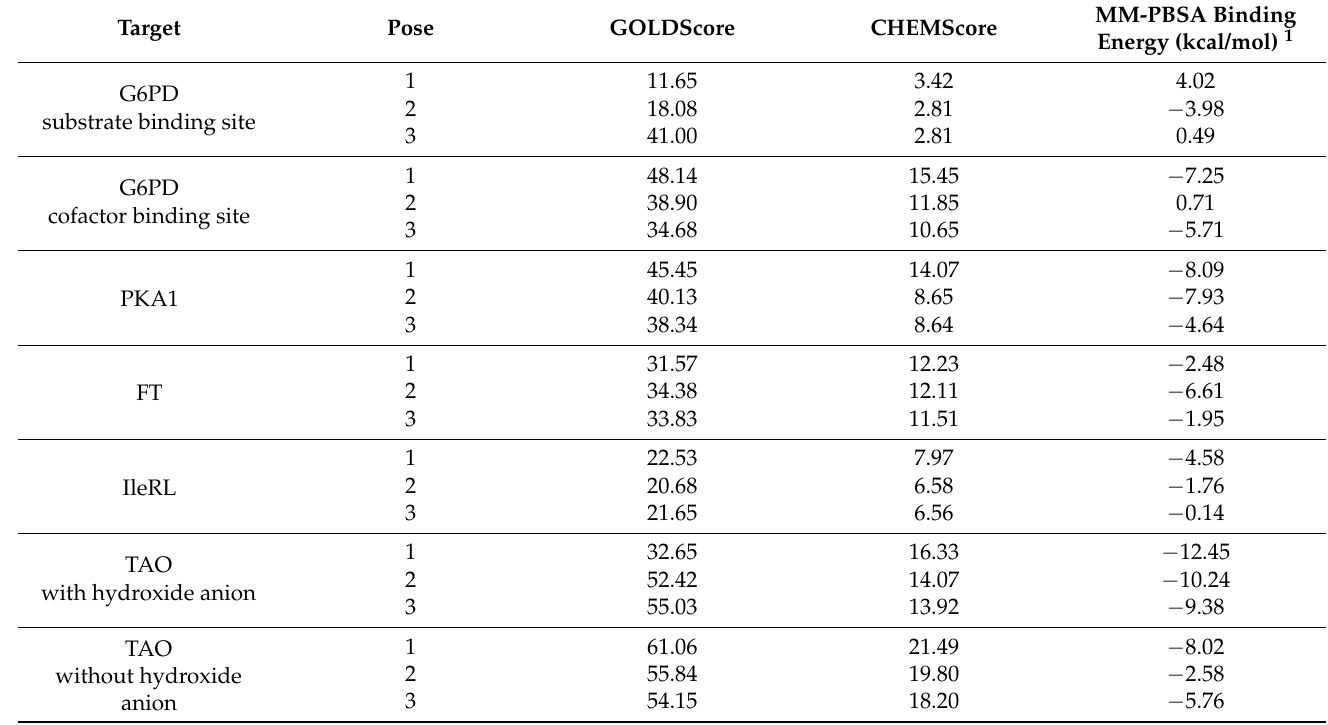
Table 4. Scoring results of molecular docking of compound 4 to potential enzyme targets and predicted free energies of the binding obtained from the molecular dynamics